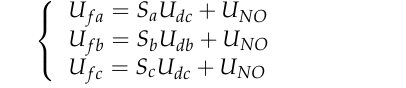
ing to the way they are connected to the grid.